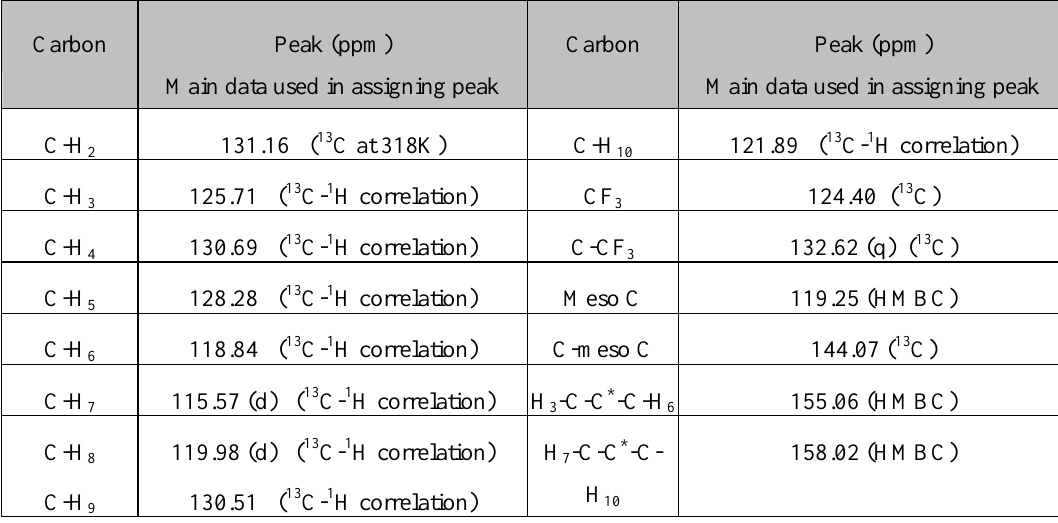
Table 3. Summary of 13 C-NMR